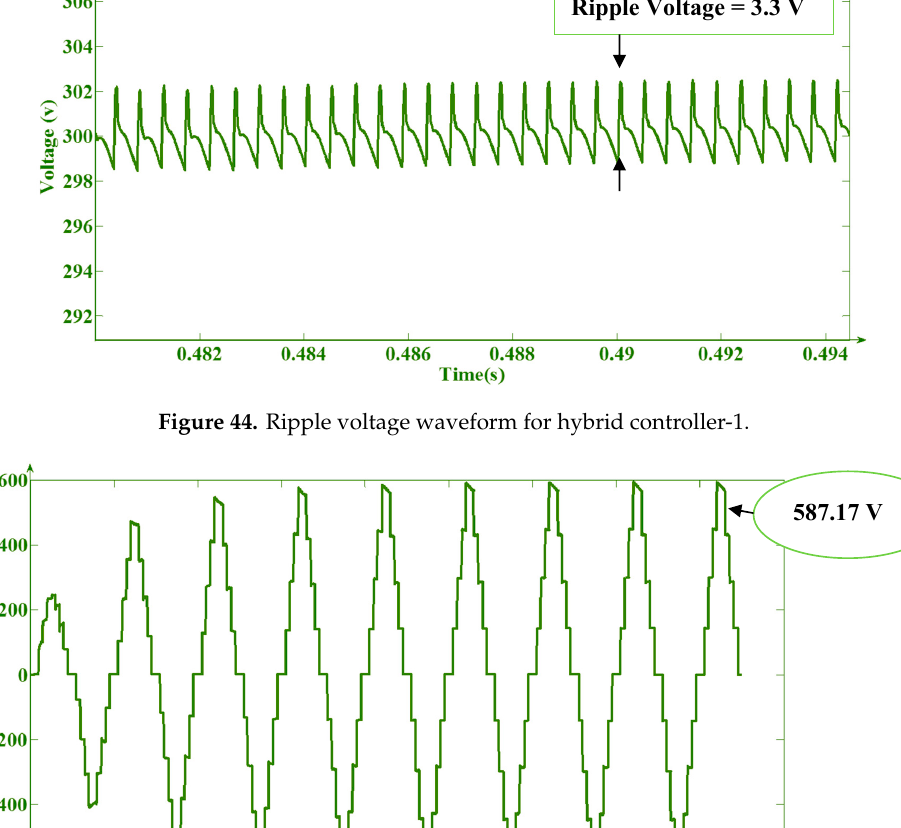
Figure 45. Output voltage for MLI with hybrid controller circuit-based BDC.